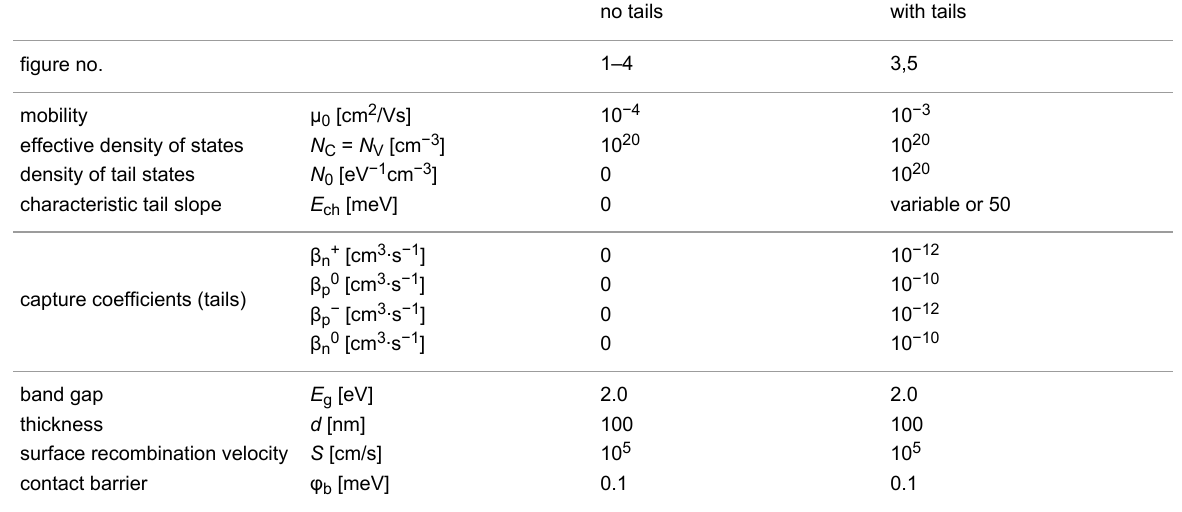
Table 1: All the parameters used in the simulations, if not stated otherwise. For the definition of the capture coefficients see Figure 2 in [39]. The contact barrier is the distance between the Fermi level and conduction band edge at both contacts. This value is kept constant for all simulations except for the one with V bi = 1 V in Figure 2, where the contact barrier at the cathode ( x = d ) is 0.1 eV and the contact barrier at the anode ( x = 0) is 1.1 eV. The relative permittivity used in all simulations is ε r = 3.8 and the capture coefficient for the Gaussian defect is 10 − 10 cm 3 ·s − 1 for electrons and holes. no tails with tails figure